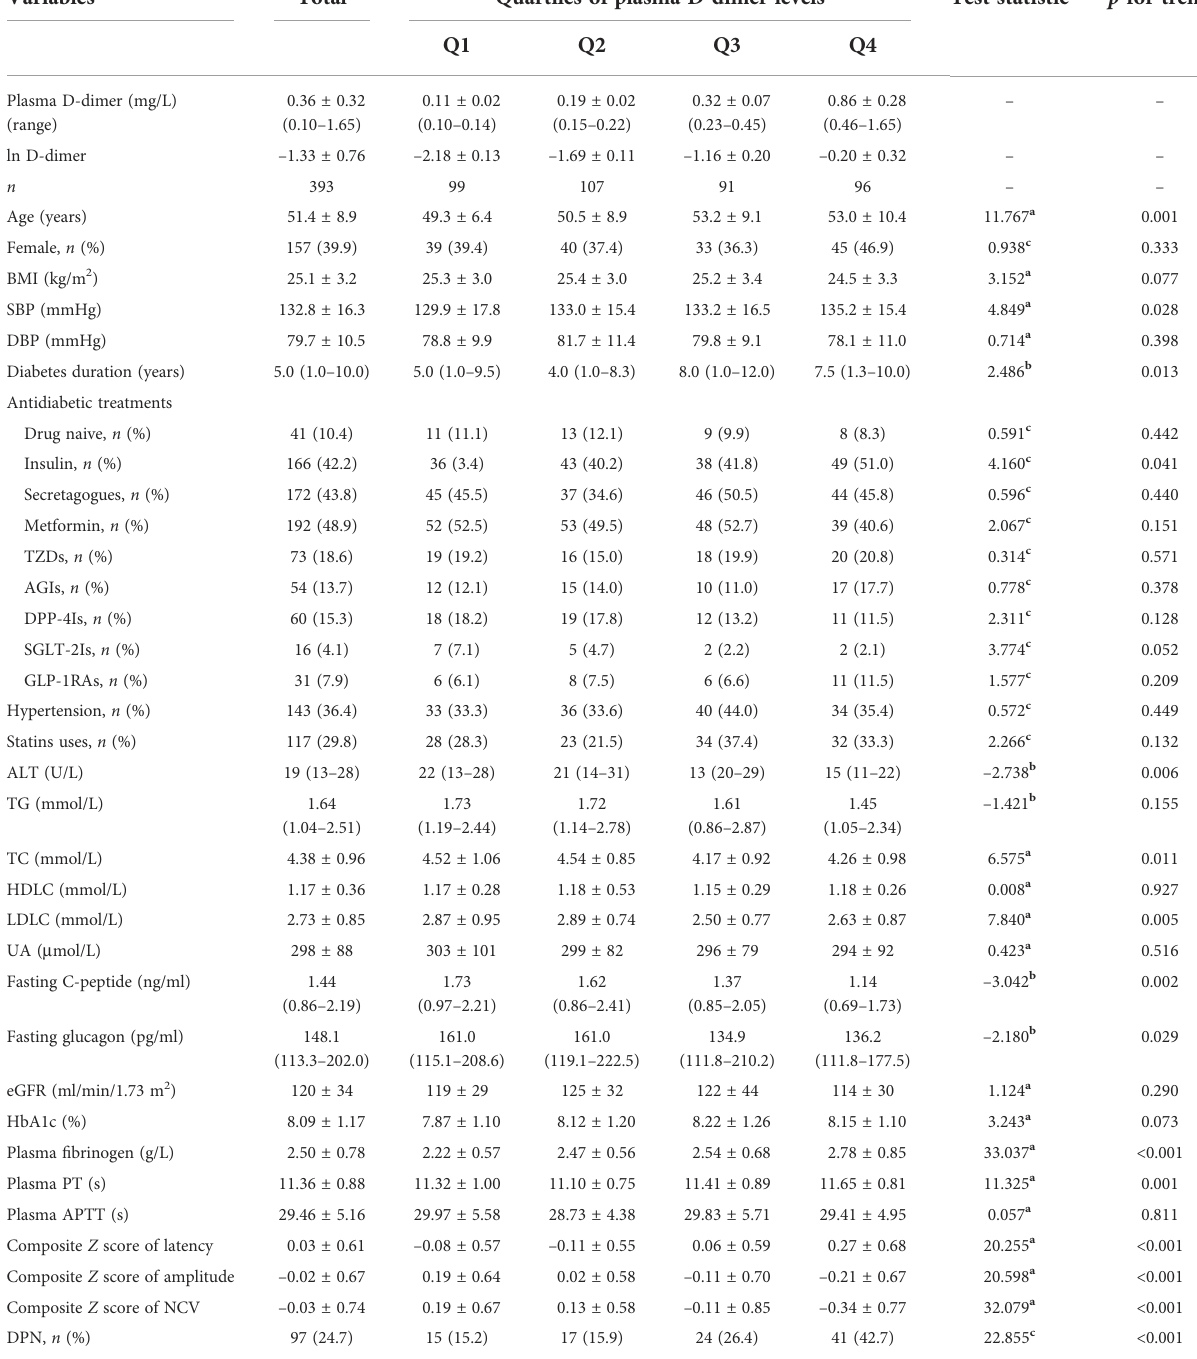
TABLE 1 Clinical features of the recruited